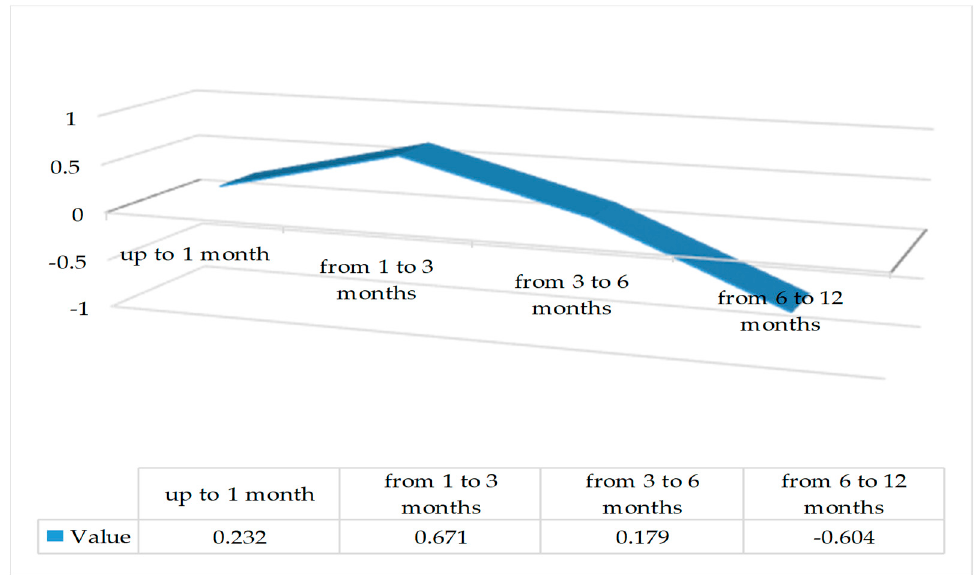
Figure 1. Diagram of the correlation between the term of stay and the uncertainty avoidance index of the labour migrants from Ukraine. Source: developed by the author based on (Migration Profile of Ukraine 2011–2015).